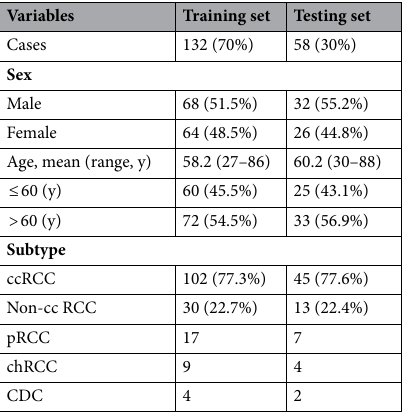
Table 1. Demographic information in two sets. ccRCC clear cell renal cell carcinoma, pRCC papillary RCC, chRCC chromophobe RCC, CDC collecting duct